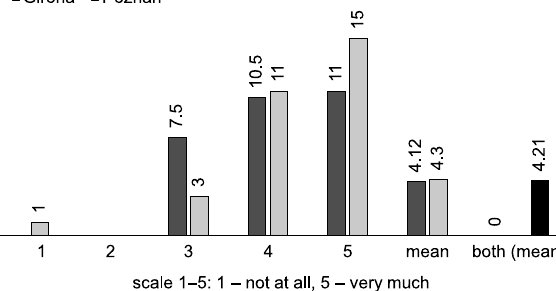
Fig. 4. Students’ satisfaction with the LBD method – the expected learning